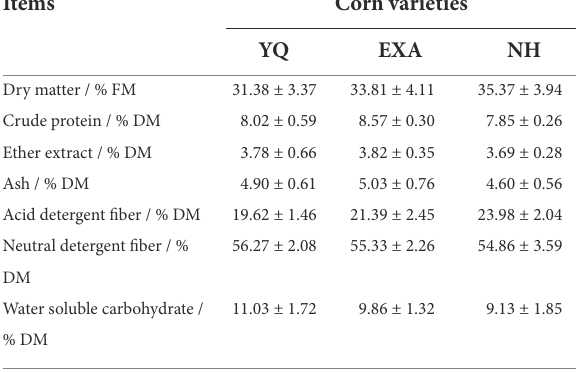
TABLE 1 Chemical composition of fresh whole-plant corn of three different varieties before ensiling (±SD, n = 3).